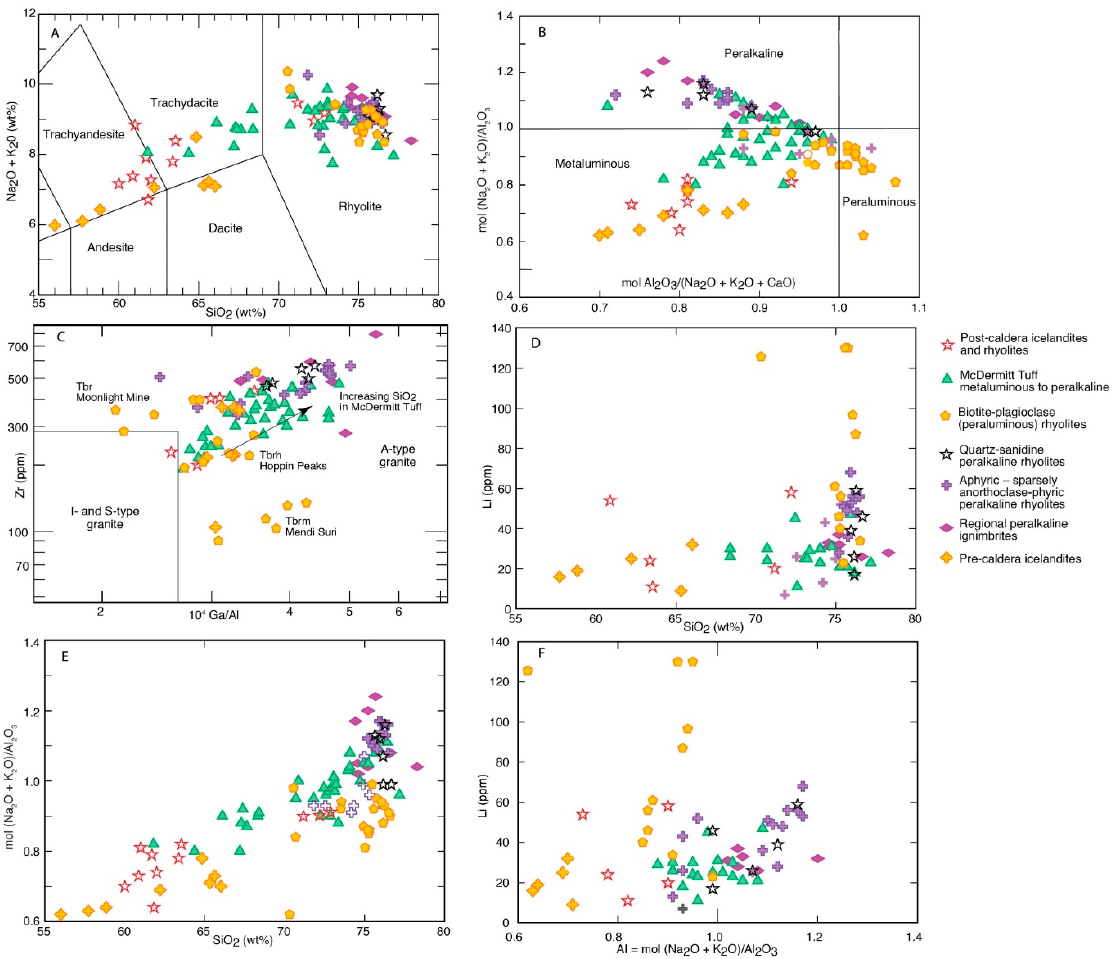
Figure 4. Geochemical characteristics of rocks of the McDermitt caldera. Data from Reference [19]. ( A ) Total alkali (Na 2 O + K 2 O)-SiO 2 . ( B ) Peralkalinity versus alumina index. ( C ) Zr versus 10 4 × Ga/Al plot. ( D ) Li–SiO 2 . ( E ). Peralkalinity versus SiO 2 . ( F ) Li versus peralkalinity.